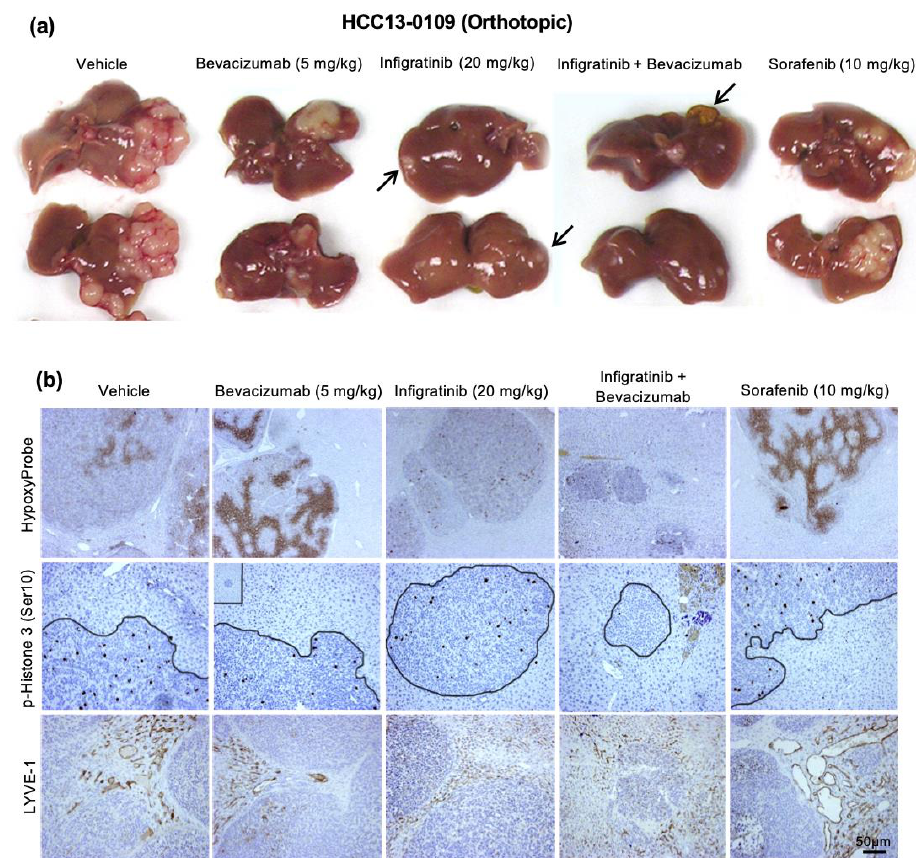
Figure 4. Effects of Infigratinib, Sorafenib, Bevacizumab, and Infigratinib / Bevacizumab on tumor growth, tumor hypoxia, tumor cell invasion, and peritumoral lymphatic vessel density in the HCC13-0109 model. The HCC13-0109 orthotopic model was generated as previously described [39]. Mice bearing tumor xenografts were treated with vehicle, 20 mg / kg Infigratinib daily, 10 mg / kg Sorafenib daily, 5 mg / kg Bevacizumab weekly, or 20 mg / kg Infigratinib daily plus 5 mg / kg Bevacizumab weekly for 28 days. Each treatment arm involved 10 independent tumor-bearing mice. Treatments were started when the tumors reached approximately 100–150 mm 3 . Representative pictures of primary orthotopic tumors ( a ), the extent of tumor hypoxia, tumor cell invasion, and proliferation, as well as LYVE-1 + peritumoral lymphaticvesseldensityinvehicle-anddrug-treatedtumorsareshown( b ). Arrowsindicatetumorresidues. Bars: 50 µ m. Sorafenib and Bevacizumab induced tumor cell invasion, micrometastasis, and significantly increased tumor hypoxia. Infigratinib significantly inhibited tumor growth and tumor cell invasion, and reduced LYVE-1 + peritumoral lymphatic vessel density and area ( p < 0.05). Combination of Infigratinib with Bevacizumab resulted in a significantly greater inhibition of tumor growth and lymphangiogenesis than Infigratinib alone ( p < 0.05). Experiments were repeated twice with similar